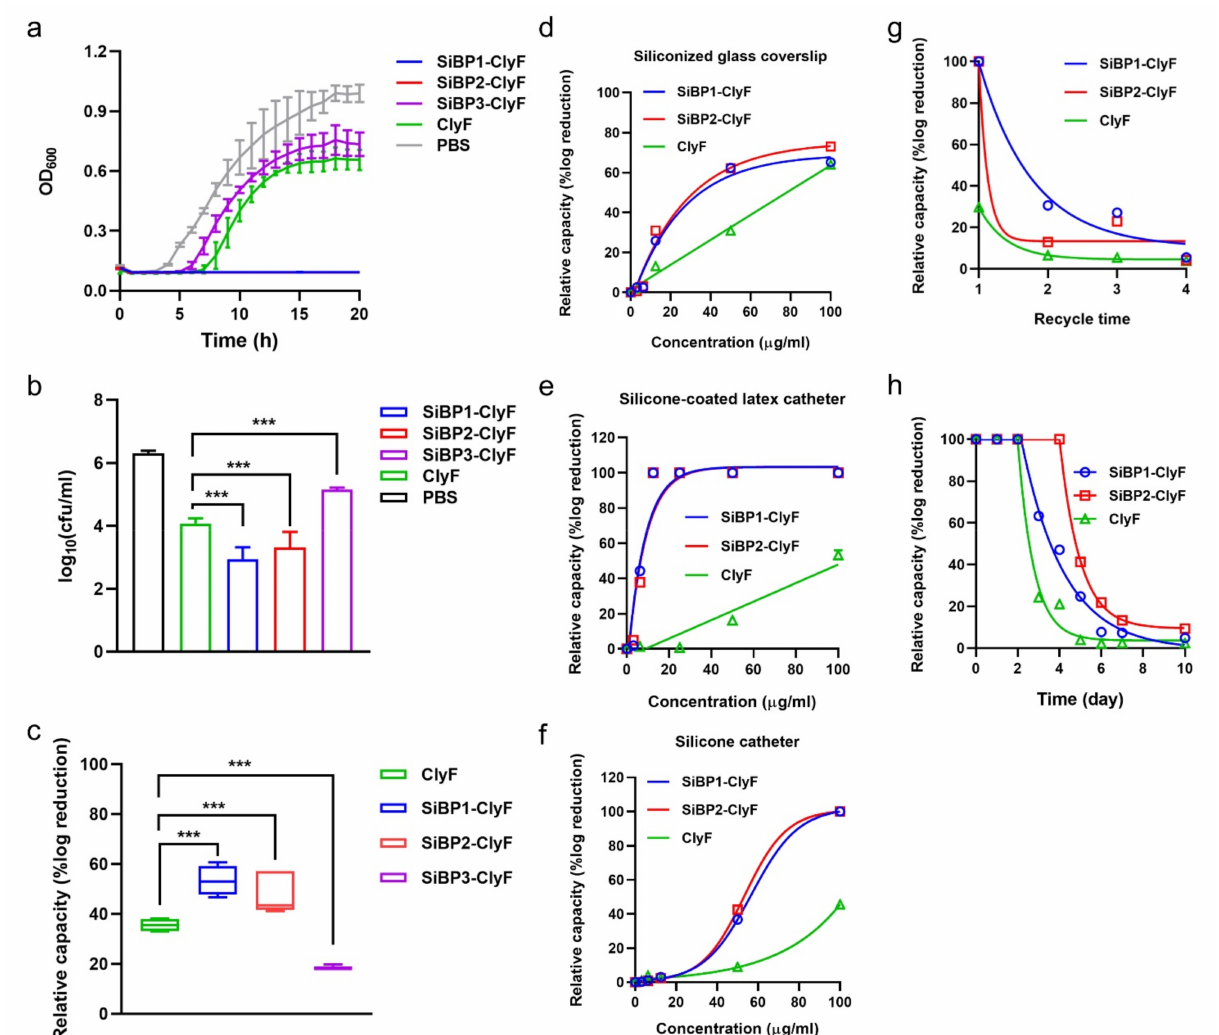
Figure 4. Bactericidal activities of immobilized ClyF and its variants against planktonic S. aureus on different surfaces. ( a ) Bacteriostatic activities of ClyF and its variants immobilized on siliconized glass surface against S. aureus N315. ( b , c ) Bac- tericidal capacities of ClyF and its variants immobilized on siliconized glass surface against S. aureus N315. ClyF and its SiBP-fused variants were immobilized on siliconized glass surfaces and cocultured with S. aureus N315 for 1 h at 37 ◦ C, residual number of viable bacteria was determined by plating serial dilutions on LB agar ( b ), and the relative capacity of each protein was presented as the percentage of log reduction in lysin-immobilized groups in comparison to the mock- immobilized PBS-treated controls ( c ). ( d – f ) Bactericidal capacities of ClyF and its variants on different immobilized surfaces. Different concentrations of ClyF, SiBP1-ClyF, and SiBP2-ClyF were immobilized on surfaces of siliconized glass coverslip ( d ), silicone-coated latex catheter ( e ), and silicone catheter ( f ) for 2 h at room temperature, the bactericidal capacity of each surface after co-culture with S. aureus N315 for 1 h was then determined by plating assay. ( g ) Recycle capacity of ClyF, SiBP1-ClyF, and SiBP2-ClyF immobilized glass 96-well plates. ( h ) Bactericidal activities of ClyF, SiBP1-ClyF, and SiBP2-ClyF immobilized glass 96-well plates after stored different times at 4 ◦ C. Data are shown as means ± standard deviations and *** represents p <